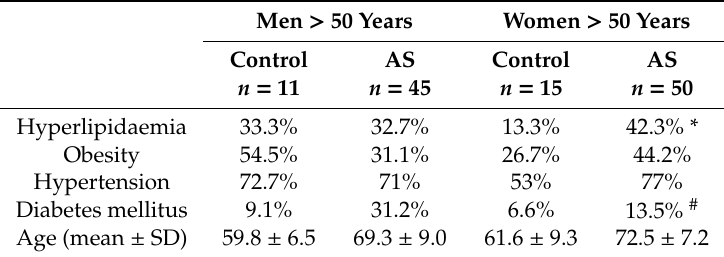
Table 1. Clinical and demographic characteristics of control and aortic stenosis patients older than 50 years.